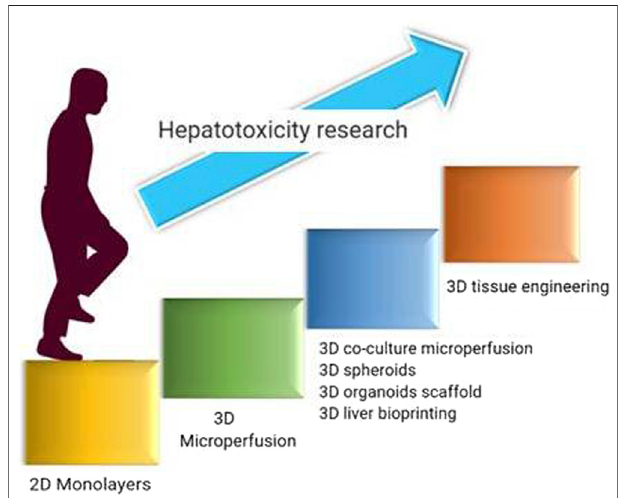
FIGURE 3 | Developmental journey in advancements of hepatotoxicity evaluation employed for nanotoxicity evaluation.